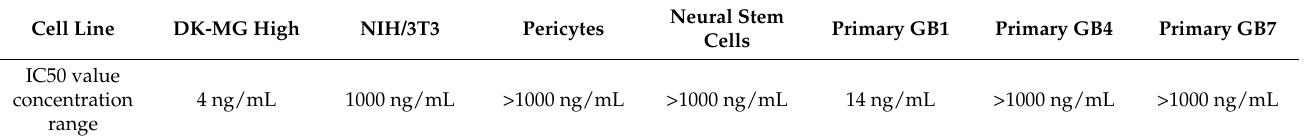
Table 3. The IC 50 values for TGF β 1 for EGFR vIII -positive neoplastic cells (DK-MG high and pri- mary glioblastoma cultures) and normal cells (NIH/3T3 fibroblasts, pericytes, and NSCs (neural stem cells) following 72-h incubation (MTT (3-(4,5-Dimethylthiazol-2-yl)-2,5-Diphenyltetrazolium Bromide)